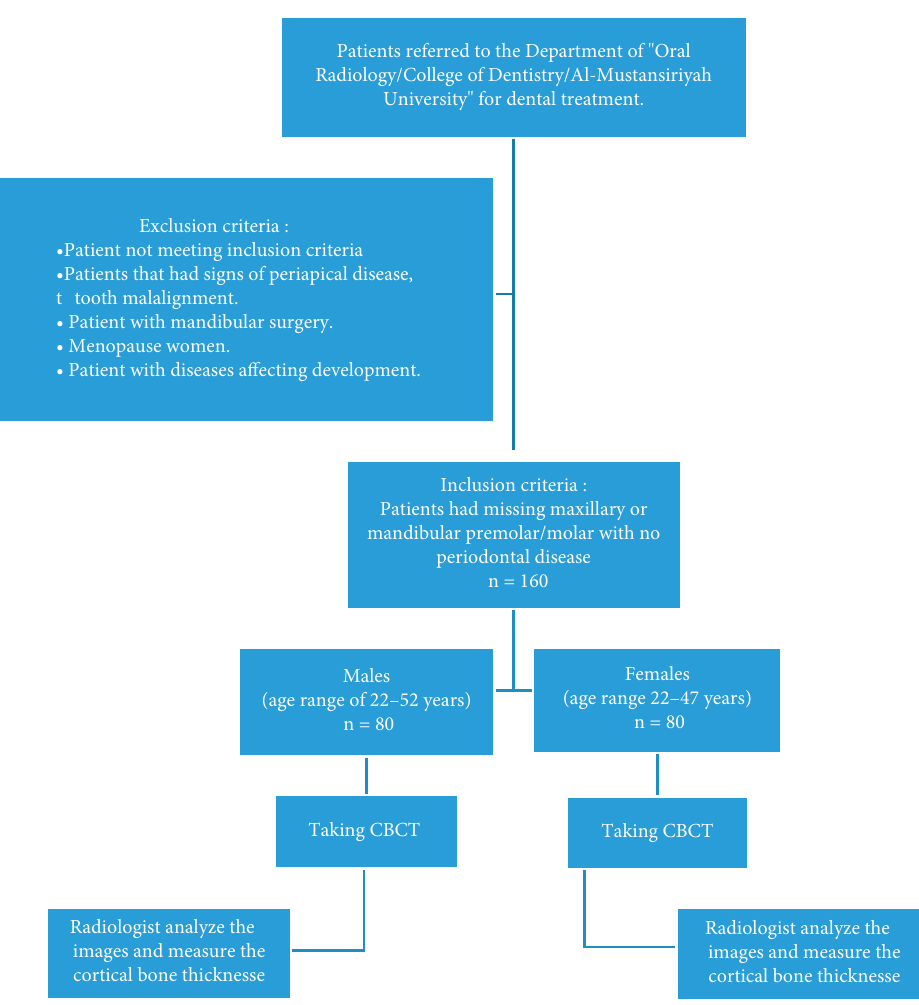
Figure 1: Flow diagram for the participants in the current study.